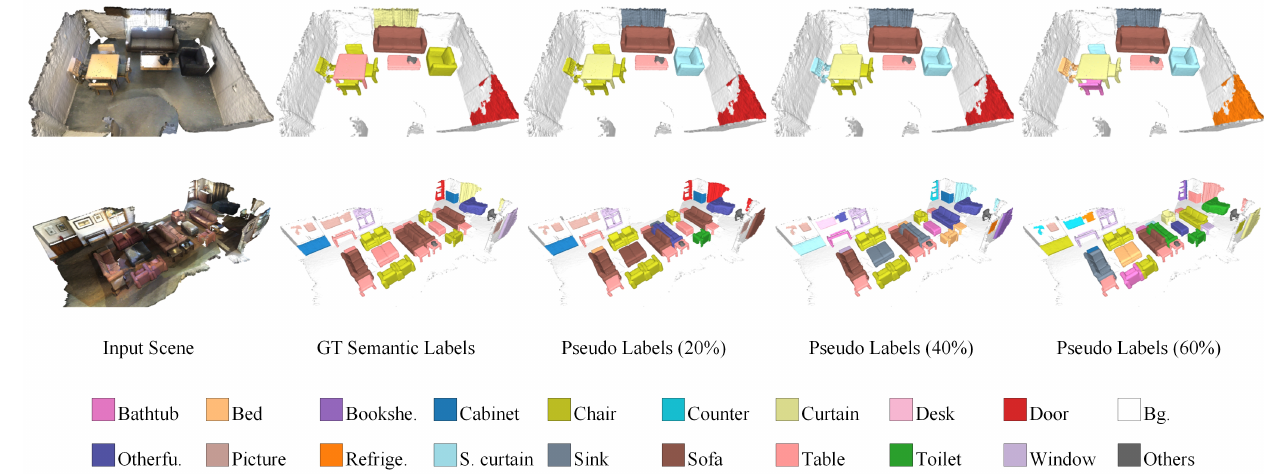
Figure 6. Visualization of different noise rates affecting the semantic labels. From left to right are the input scene, the ground-truth semantics, and the pseudo-labels of noise rates of 20%, 40%, and 60%. The higher the noise rate, the more chaotic the